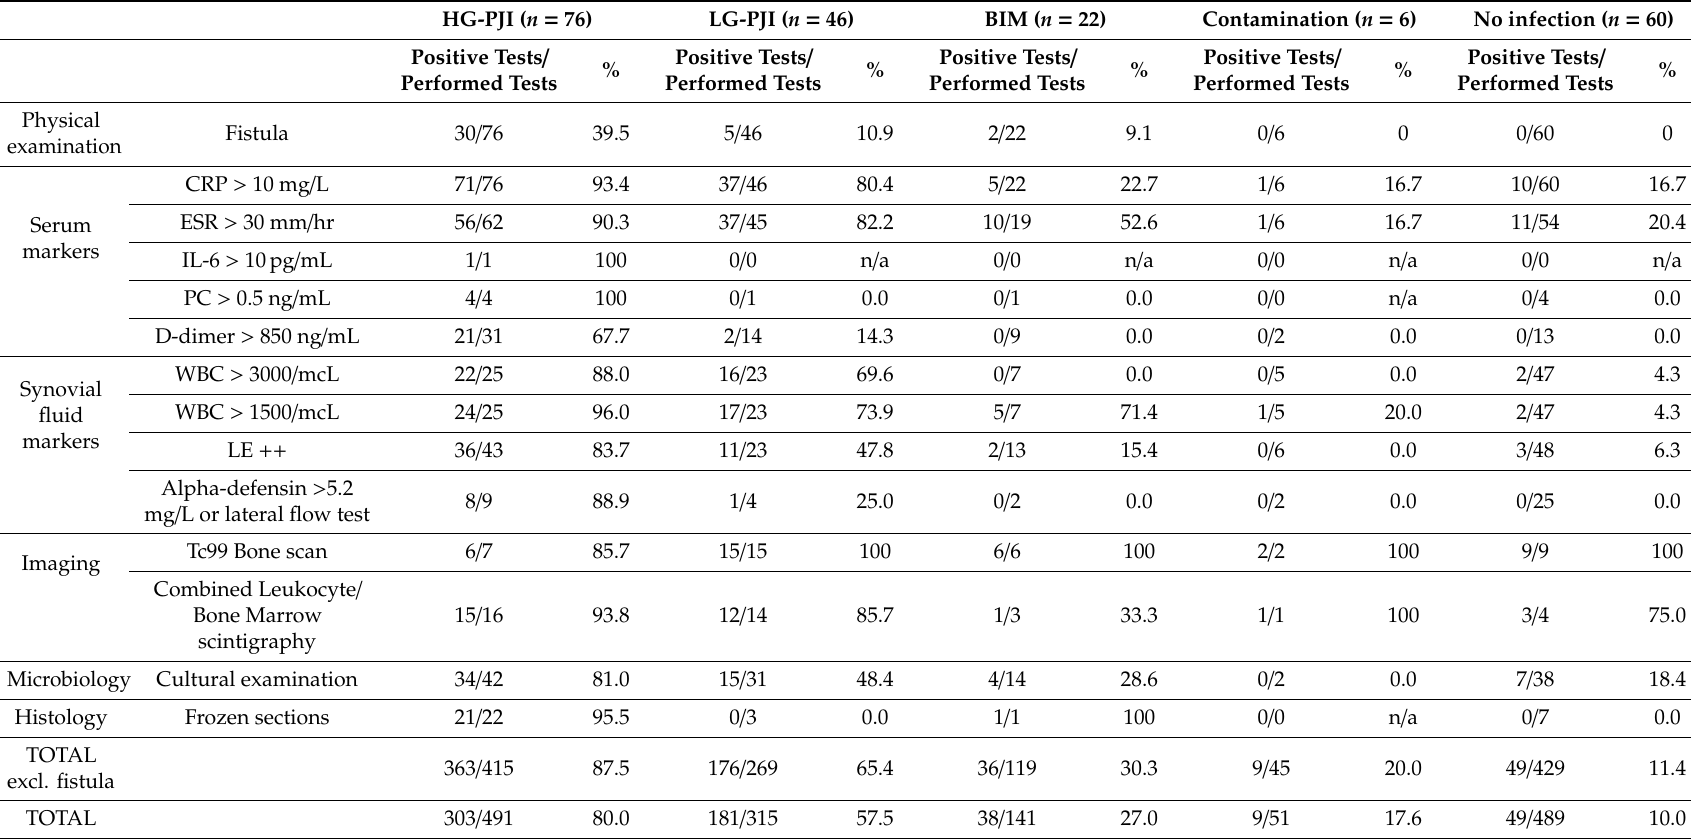
Table 5. Tests found positive in the five groups of patients, classified according to the WAIOT